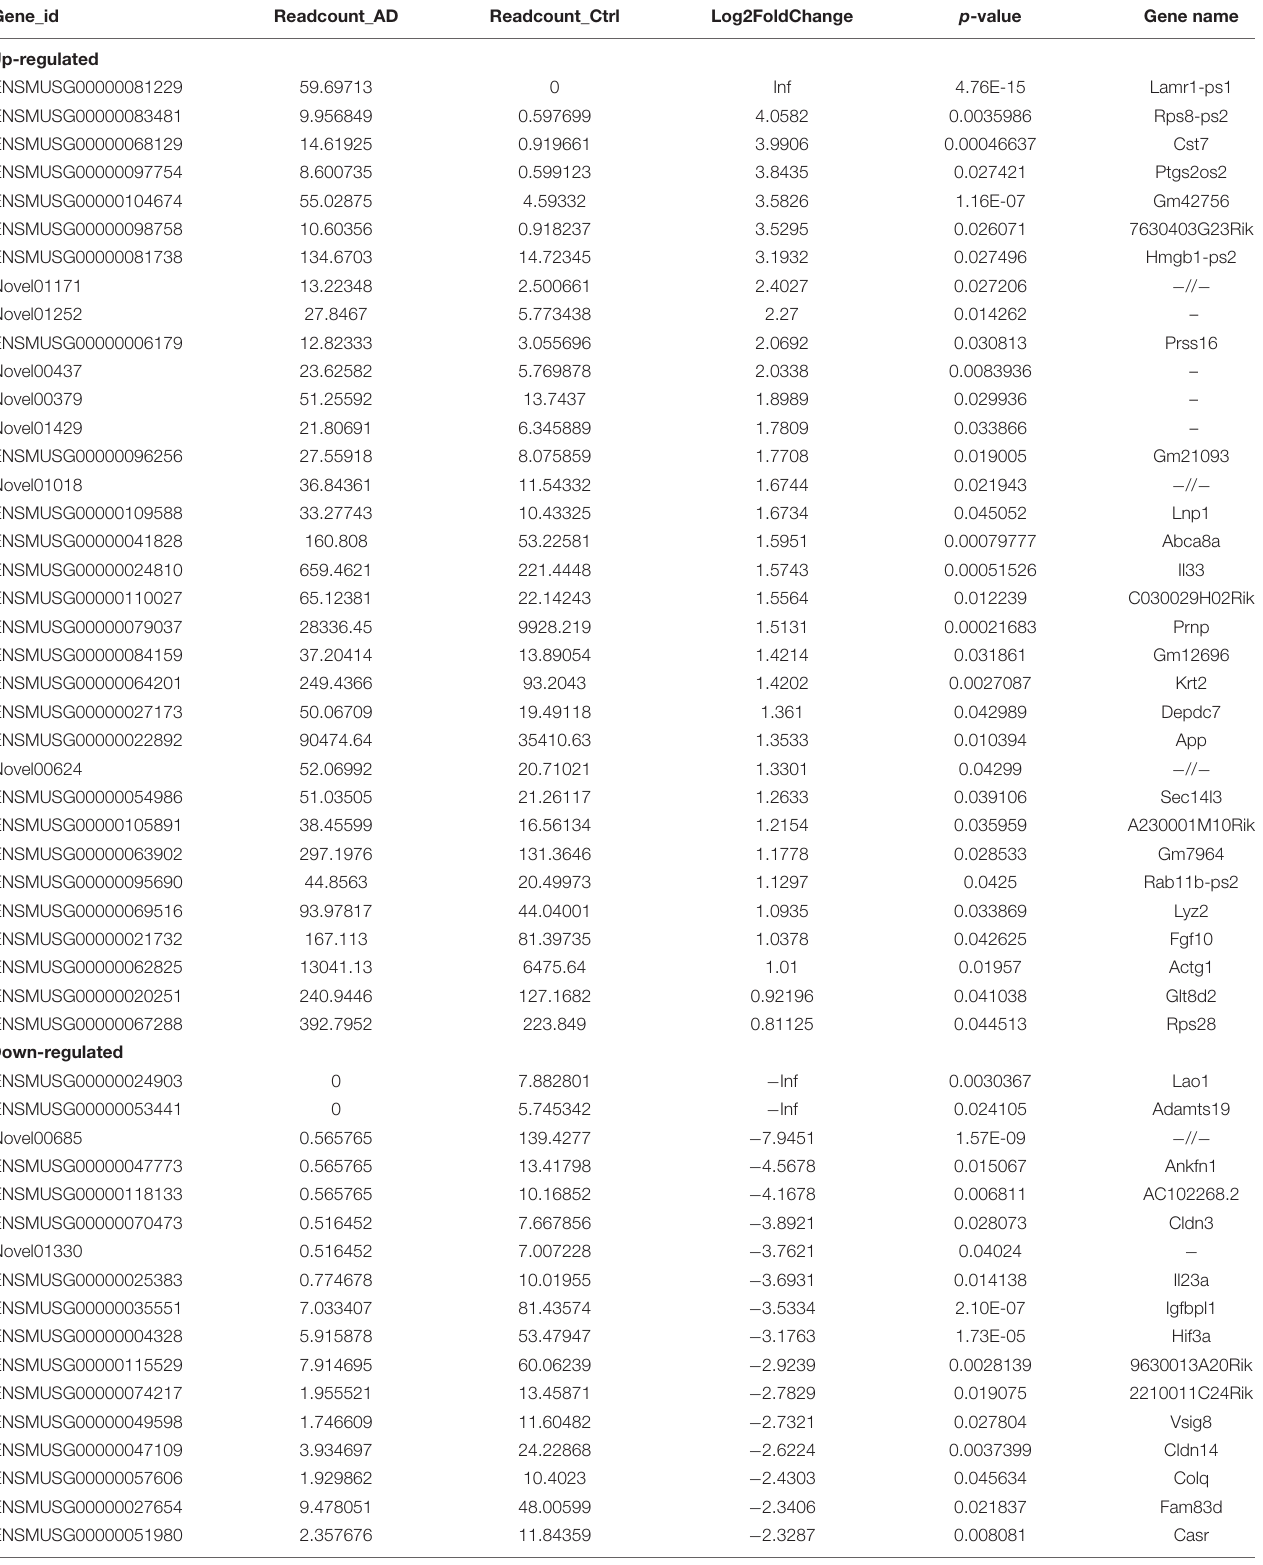
TABLE 3 | Differently expressed mRNAs between APP/PS1 and WT